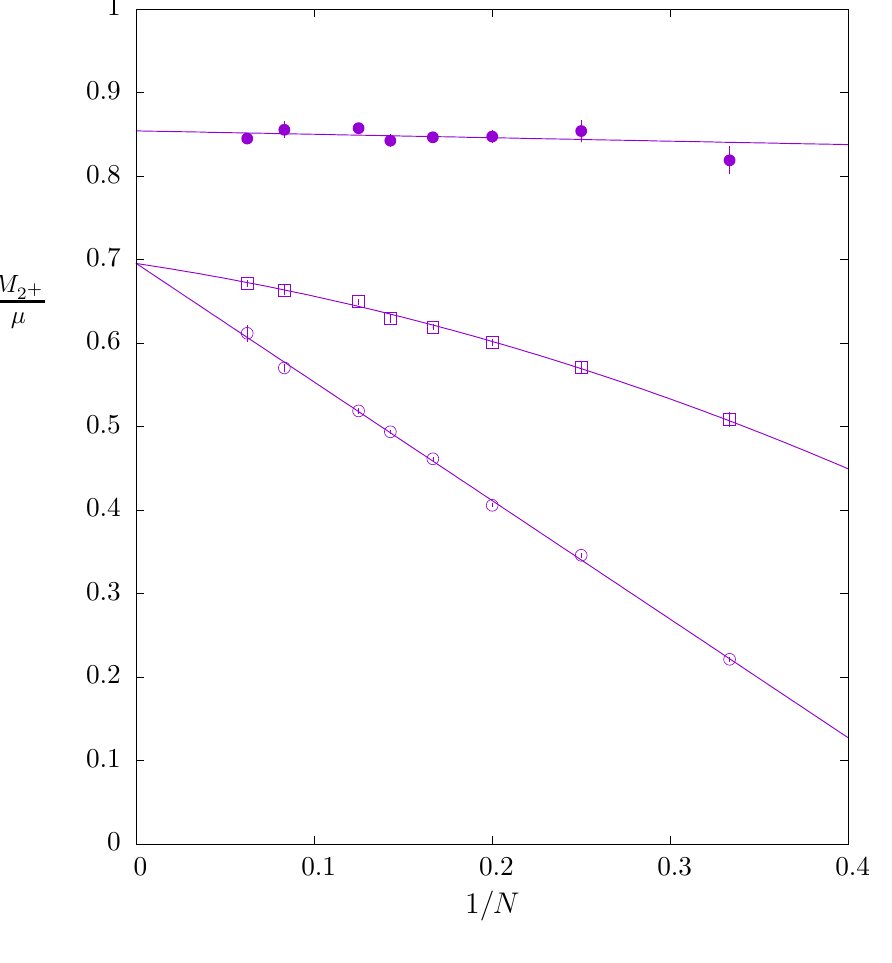
=(cid:22) versus 1 =N for (cid:22) = 2 M 2 +